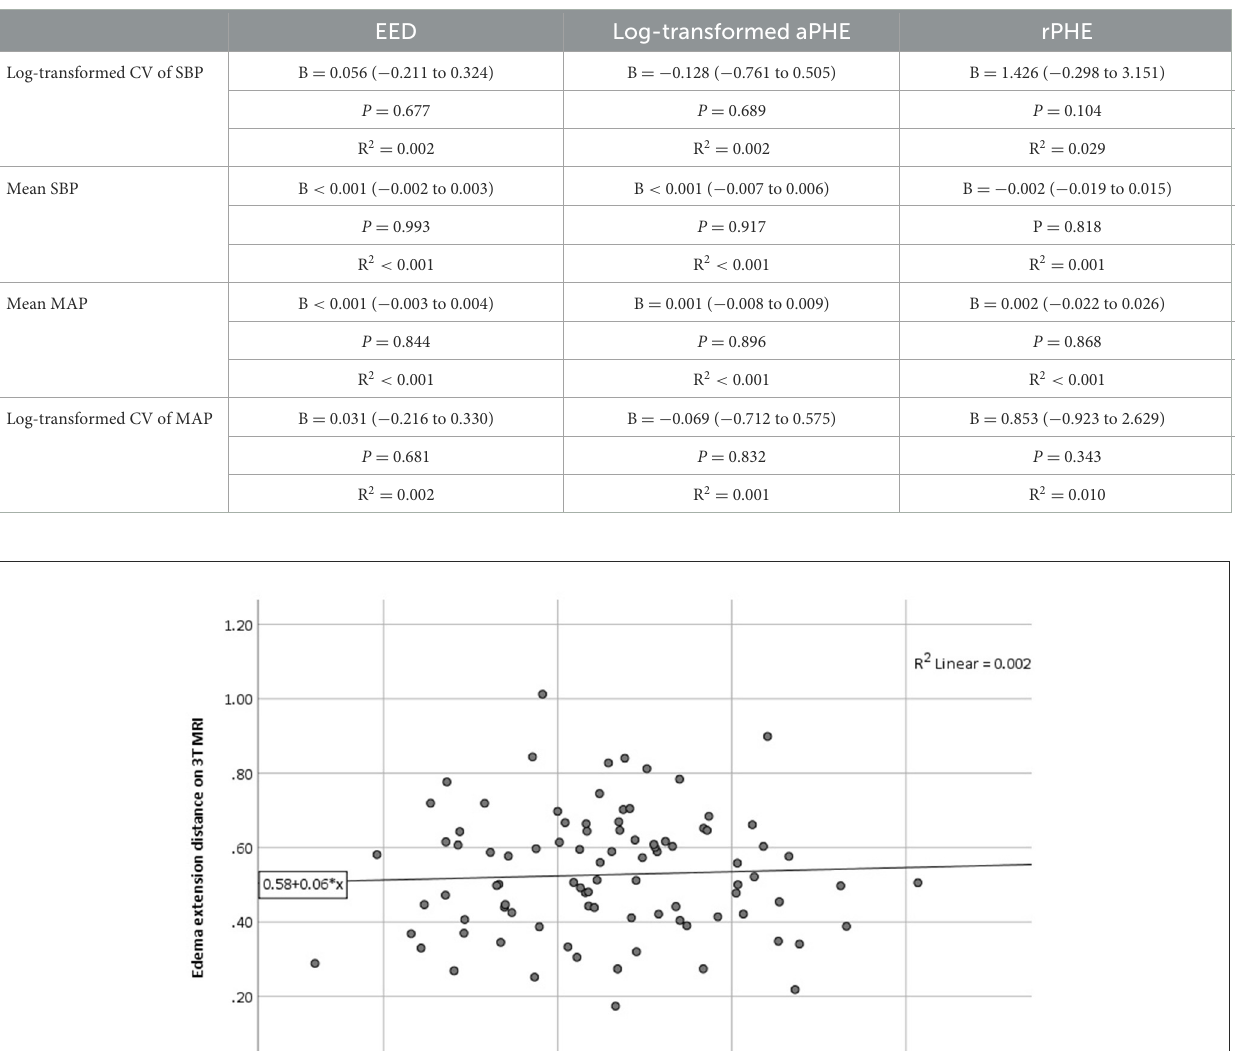
TABLE 2 Univariable regression analyses for the influence of different BP measurements in the first week on PHE as measured by EED, aPHE, and rPHE on 3T MRI.